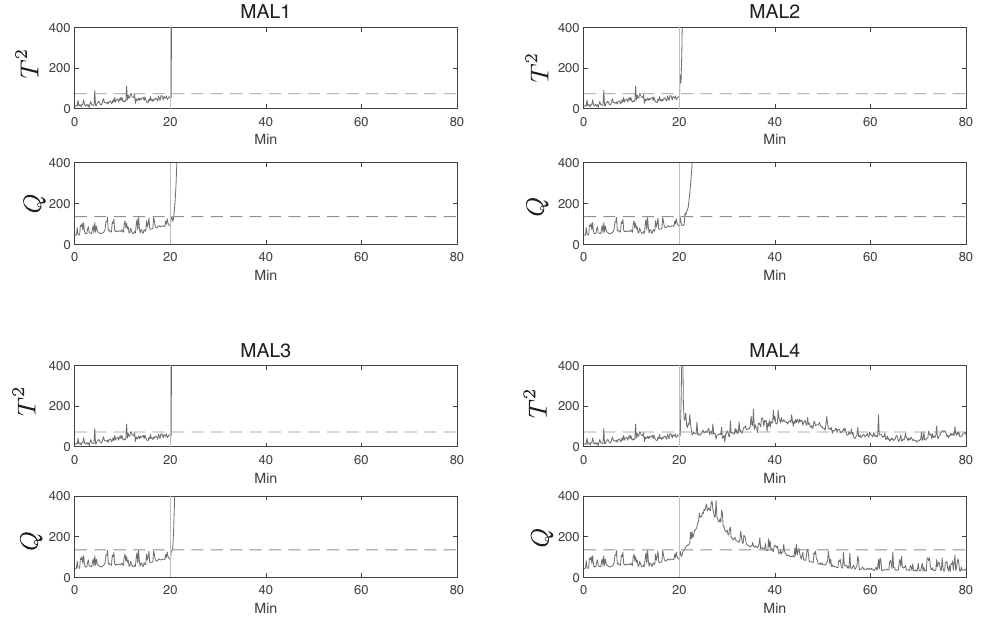
Figure 3. Fault detection results from twenty minutes before to one hour after the fault occurrences of MAL1–MAL4 by